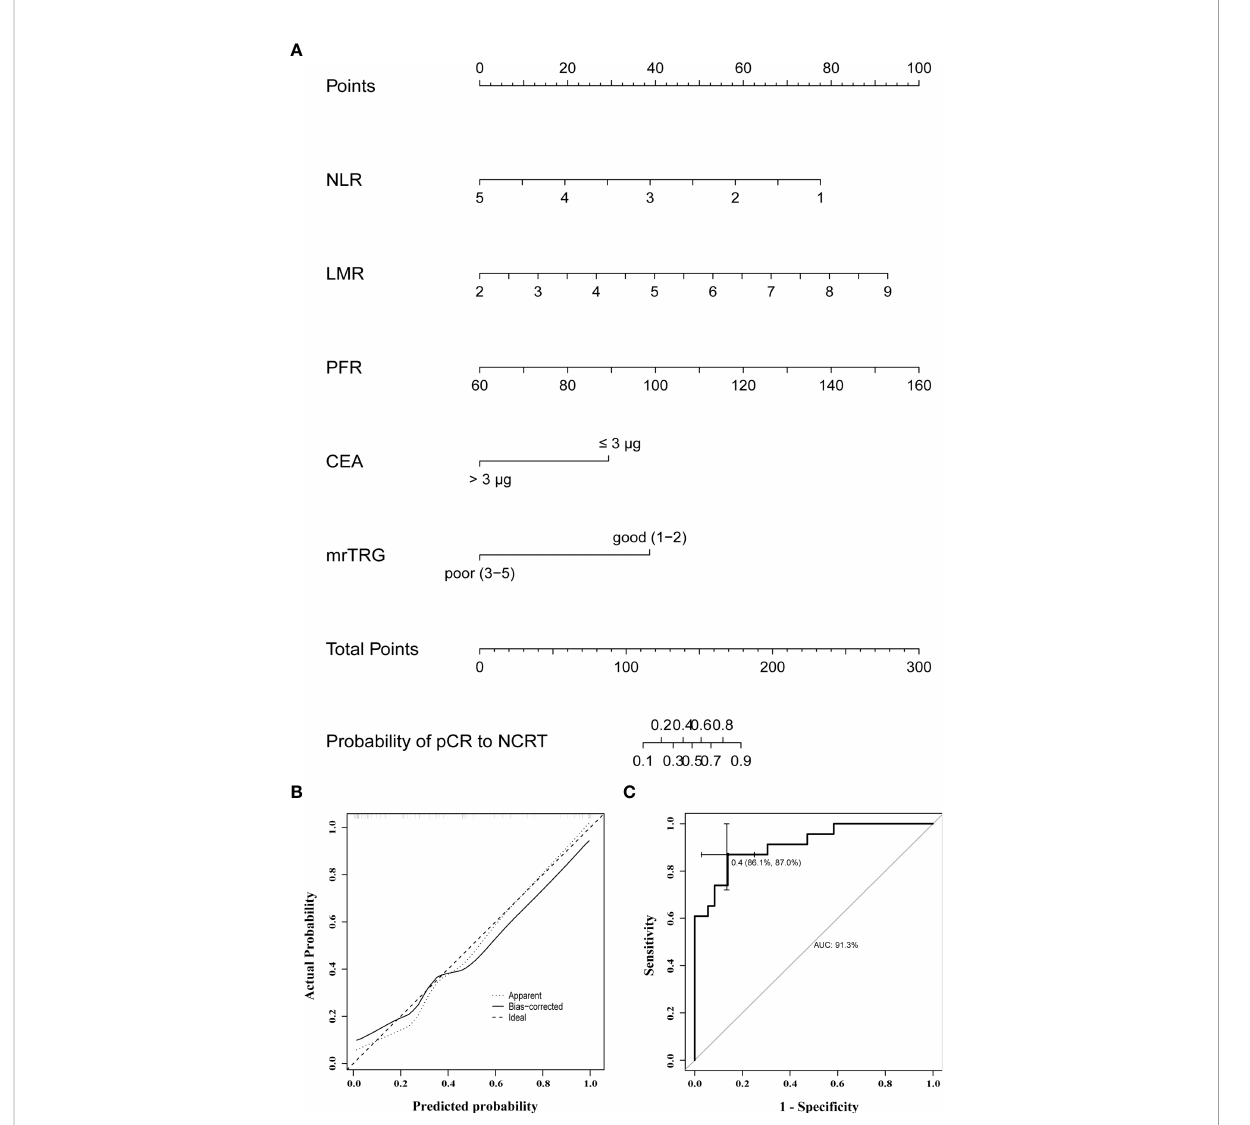
FIGURE 3 (A) A nomogram for predicting the probability of pCR to NCRT in LARC patients; (B) curves with internal validation for the nomogram; (C) ROC analysis of the nomogram. NCRT, neoadjuvant chemoradiotherapy; pCR, pathologic complete response; mrTRG, tumor regression grade assessed by magnetic resonance imaging; NLR, neutrophil to lymphocyte ratio; LMR, lymphocyte to monocyte ratio; PFR, prealbumin to fi brinogen ratio; CEA, carcinoembryonic